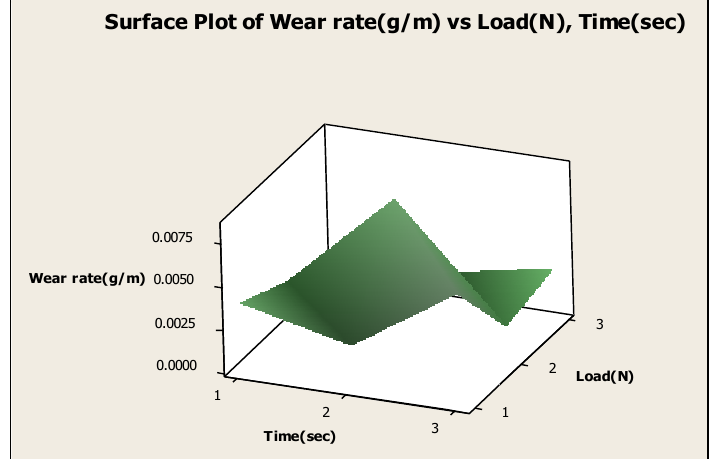
Figure 16: Surface plot of wear rate against load and time at low speed. Source: Authors, (2022).